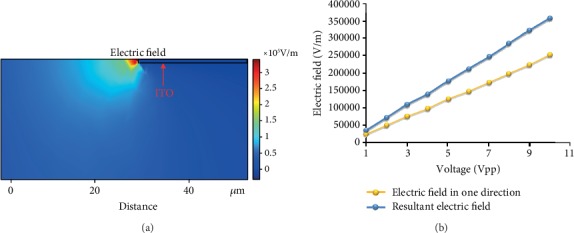
(a) Simulation diagram of the electric field in the middle part of ITO electrode 1; (b) diagram of the resultant electric field and the electric field in one direction.